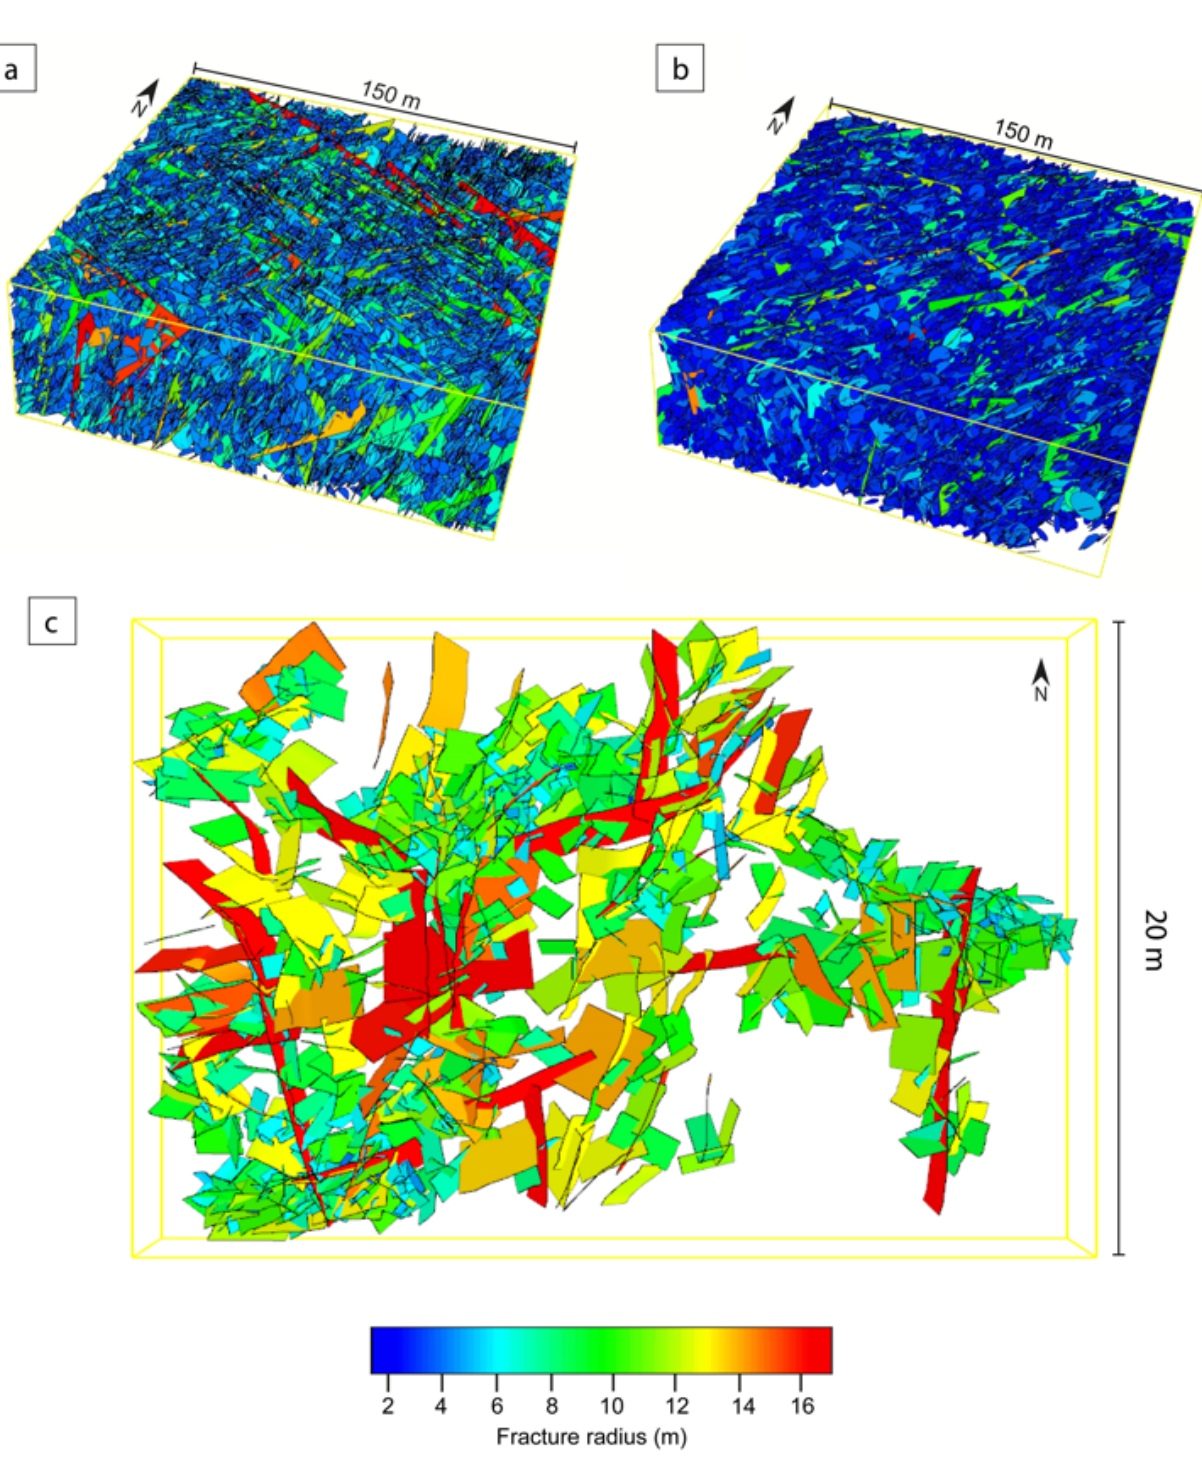
Figure 6. Semi-artificial DFN models, ( a ) Case n°1: Heat-storage purpose (800 m depth in a granodi- oritic unit), ( b ) Case n°2: Deep-geothermal faulted granitic reservoir (4000 m), ( c ) deterministic model for case 1.